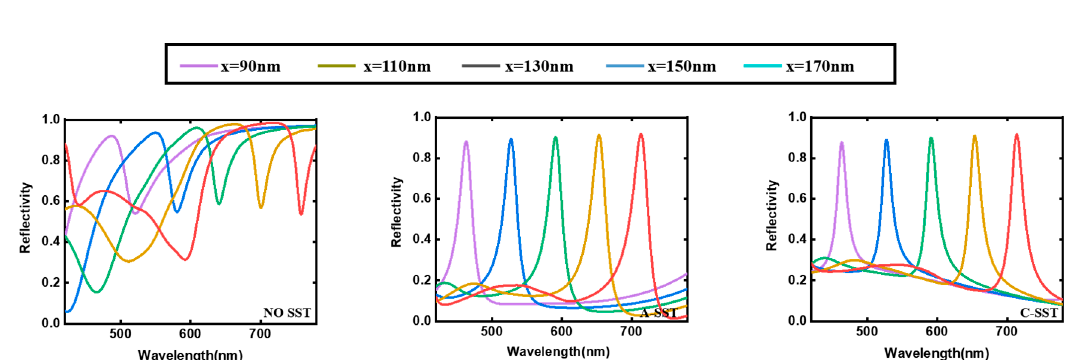
Figure 4. Reflectivity of MIMIP structure under vertical incident light.